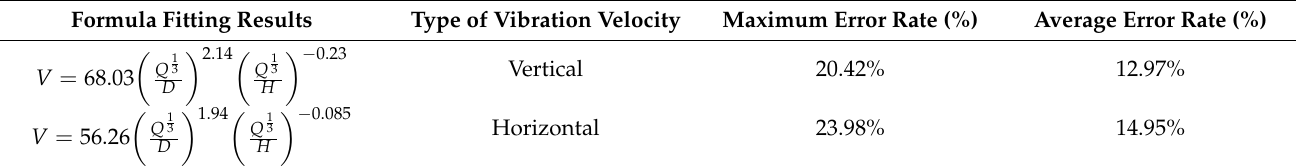
Table 2. The error rate statistics of the prediction